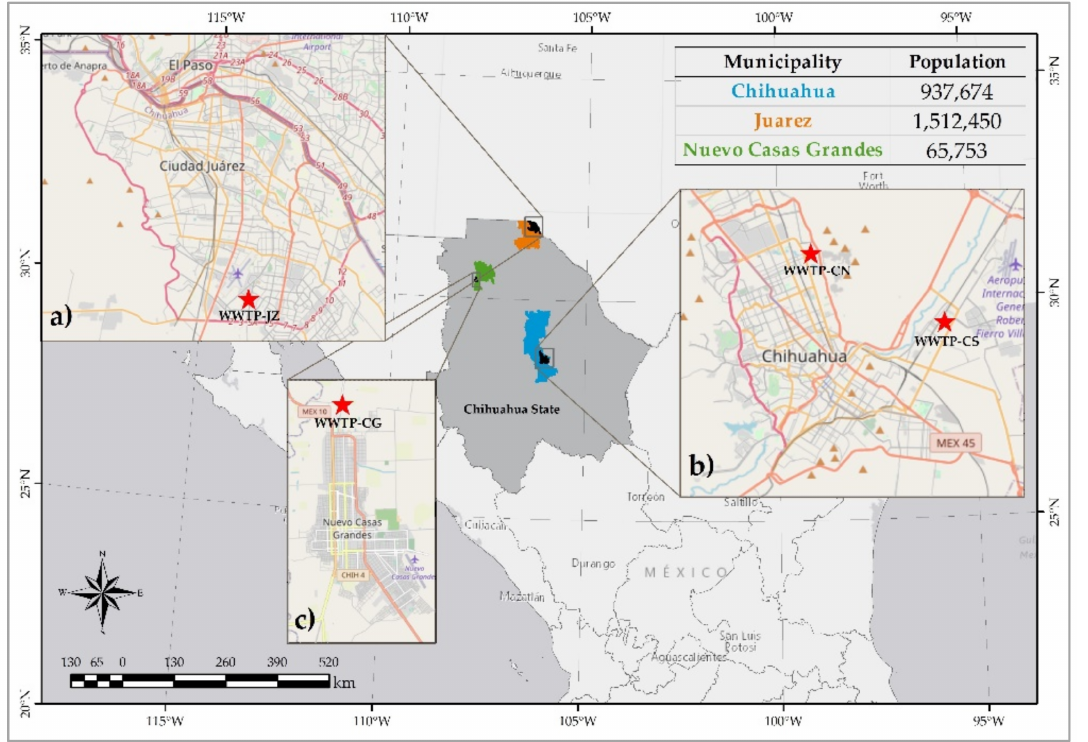
Figure 1. Localization of the WWTPs in the Chihuahua State, northern Mexico; the population size of each city is included in a table at the top-right of the